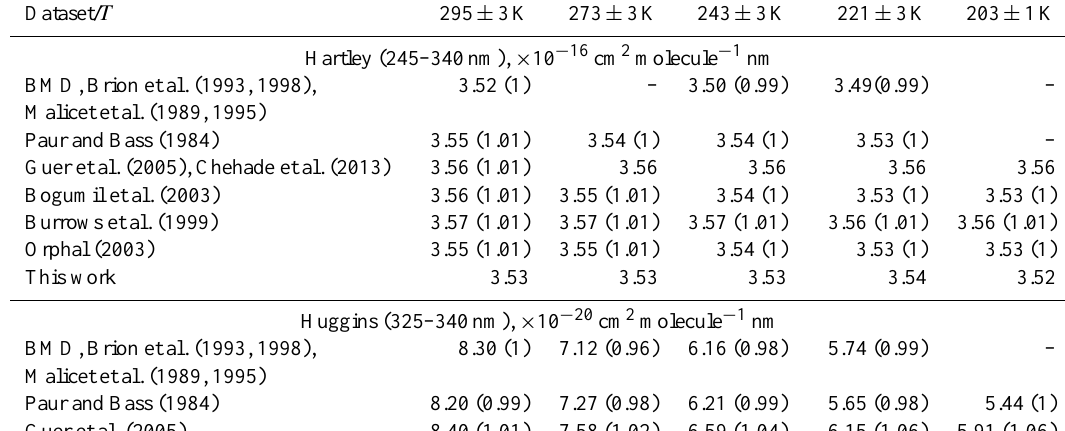
Table 3. Integrated cross-sections, and their ratios (in brackets) to our new dataset. Dataset/